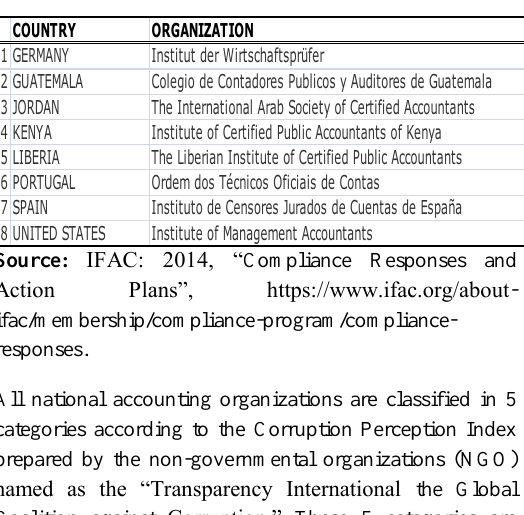
Table 5: Accounting Organizations that Do Not Apply and Consider Applying the IFAC Code of Ethics